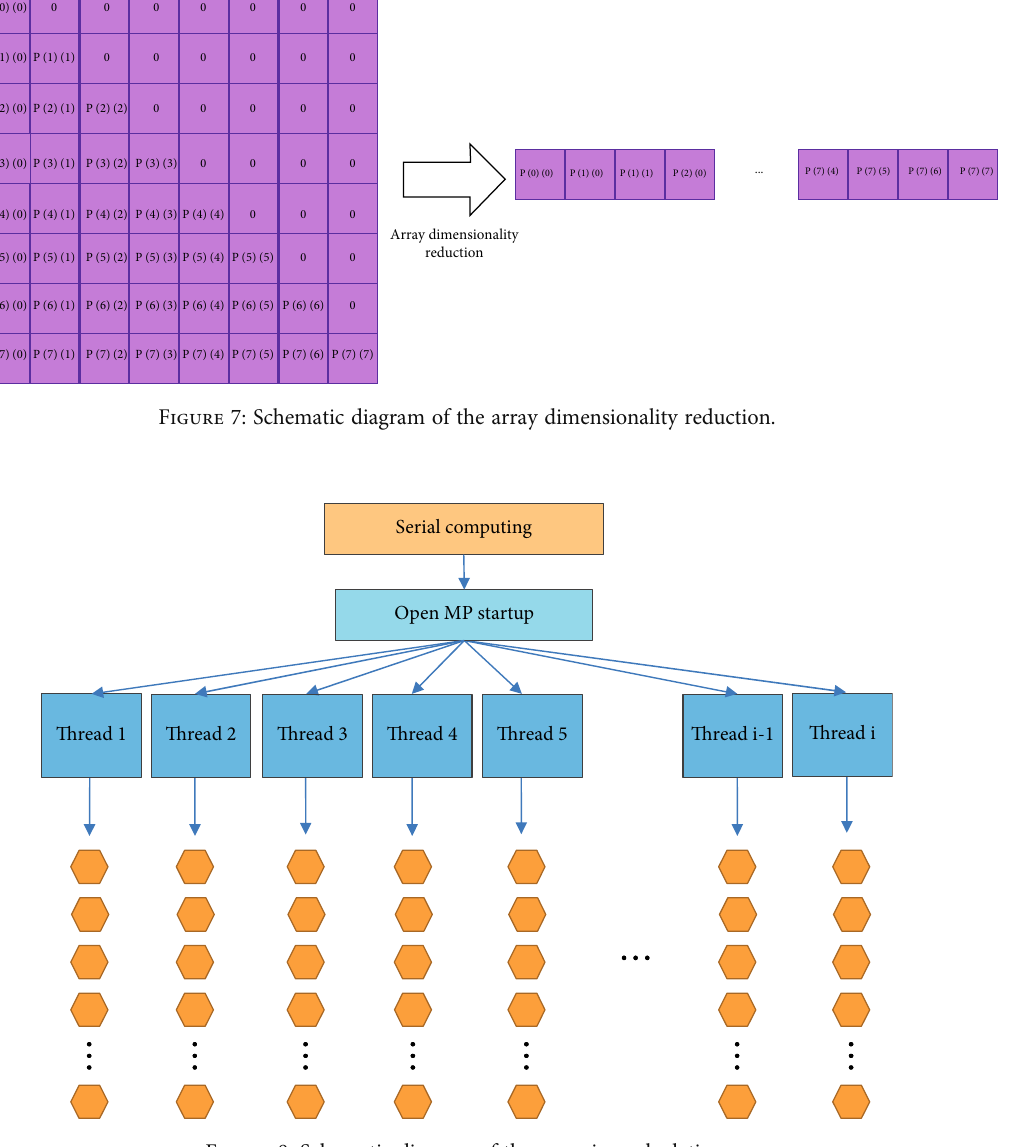
Figure 8: Schematic diagram of the grouping